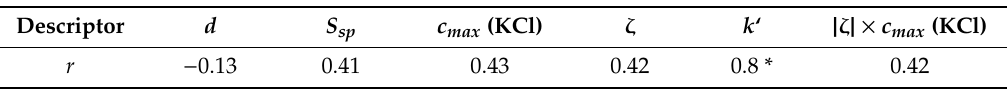
Table 7. Pearson linear correlation coe ffi cient ( r ) values for silver NP dispersion descriptors and their toxicity for Danio rerio embryos log 10 (LC 50